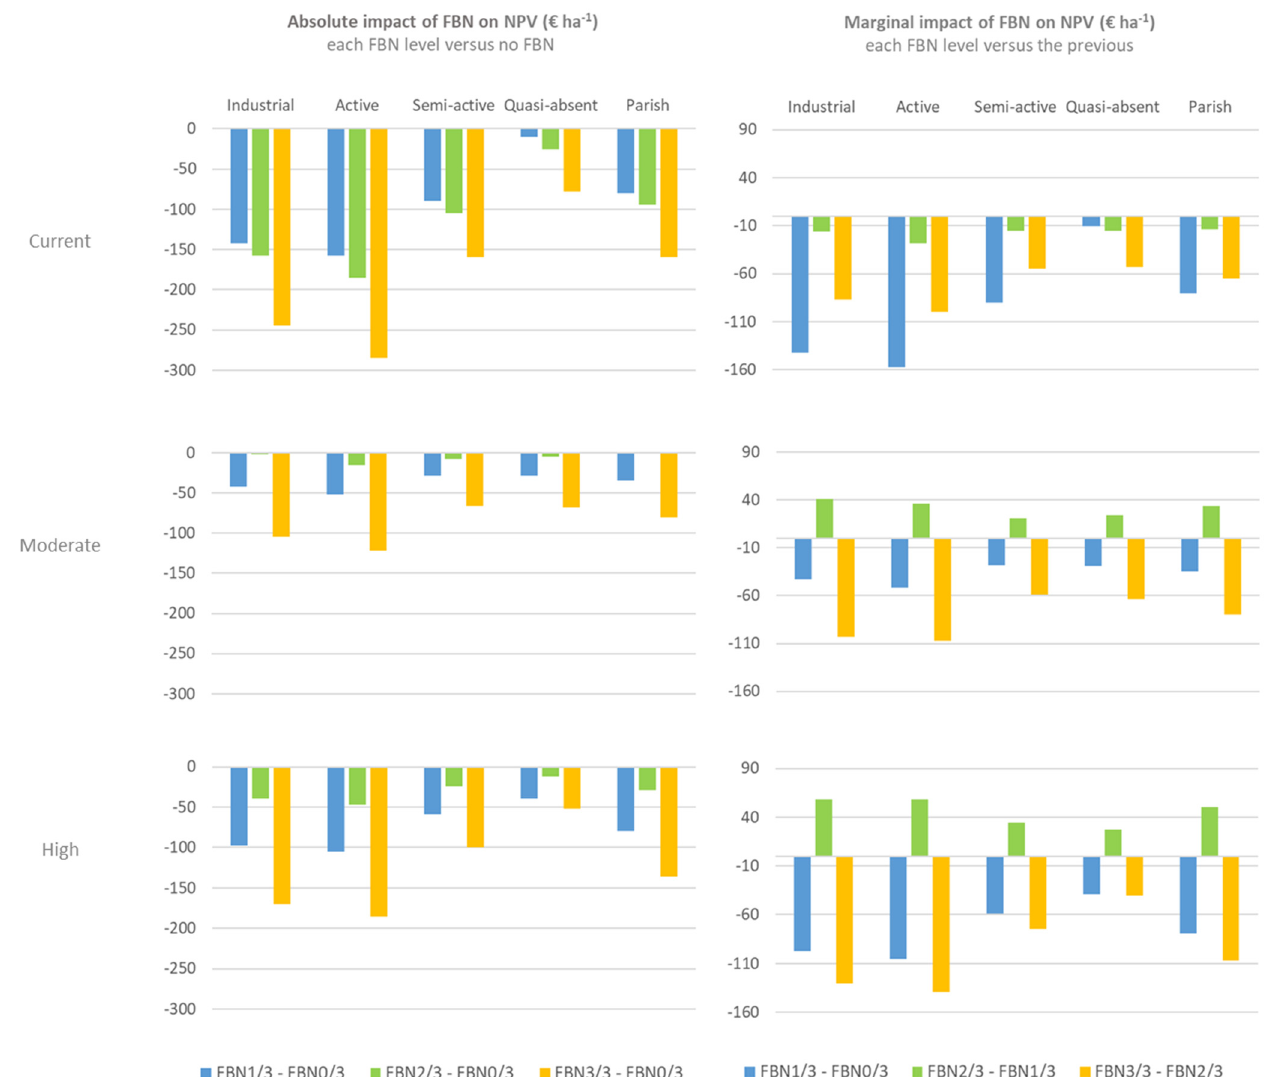
Figure 7. Absolute and marginal impact of FBN implementation on NPV per hectare by owner type and management level.